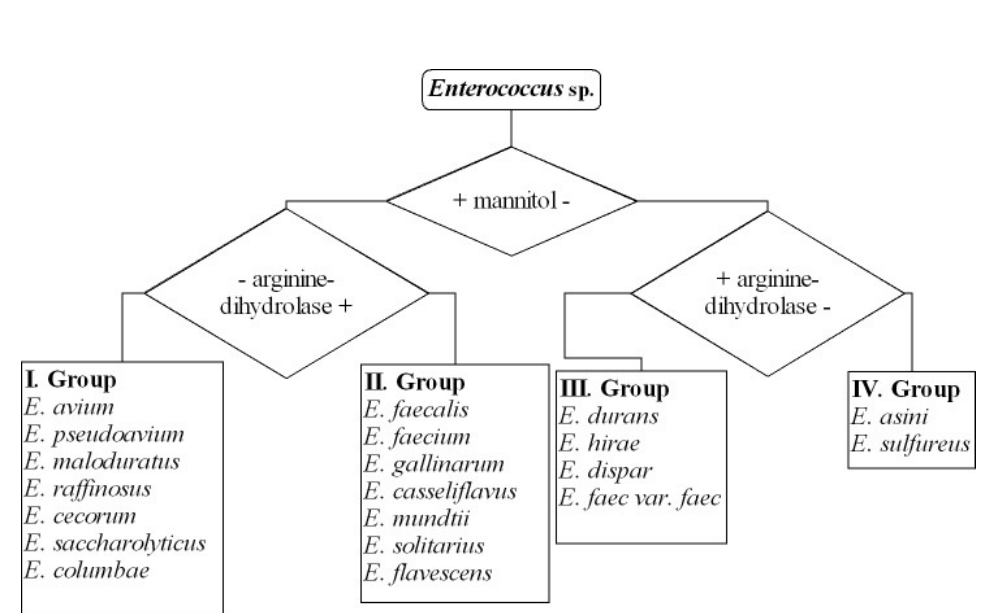
Figure 21. Identification of enterococci by biochemical